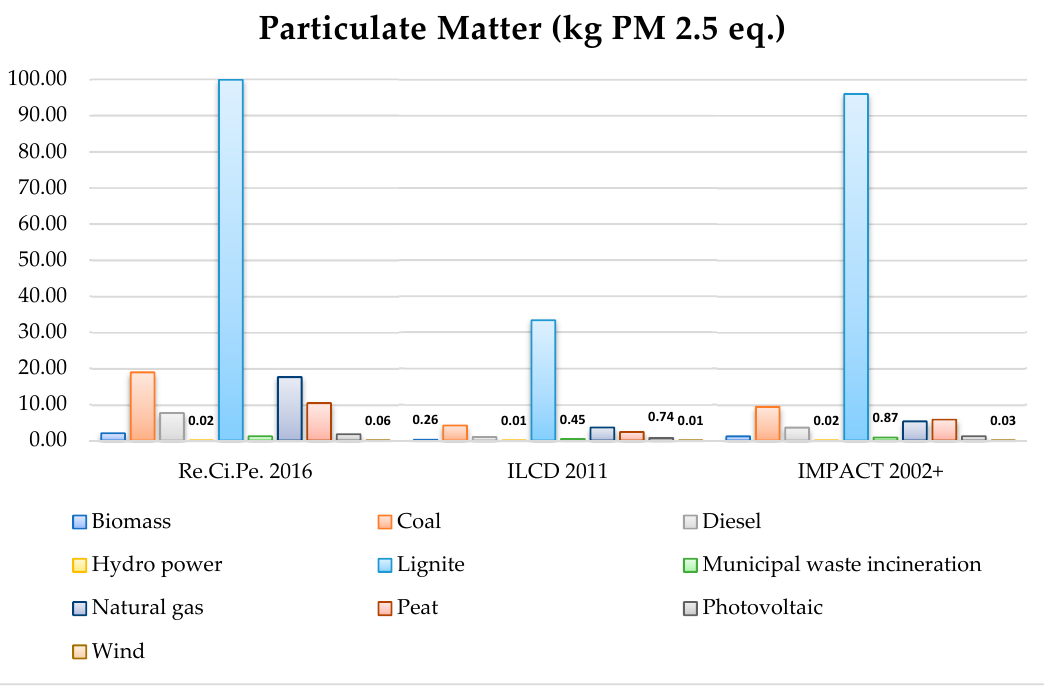
Figure 5. Comparison of the particulate matter category using midpoint methods, expressed as a relative percentage.